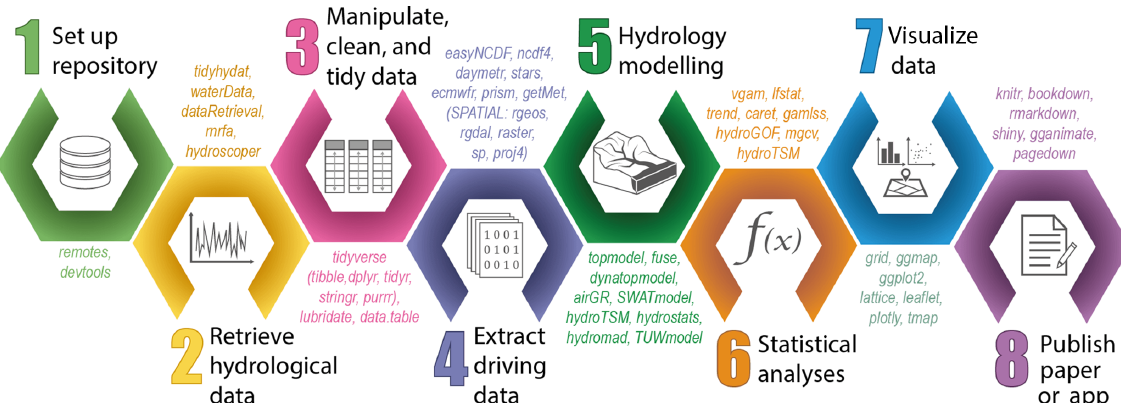
Figure 3. A typical hydrological workflow in R, containing eight steps. A selection of relevant R packages used within each script is indicated in coloured text; these packages are described in further detail in Sect. 3.1 to Sect.